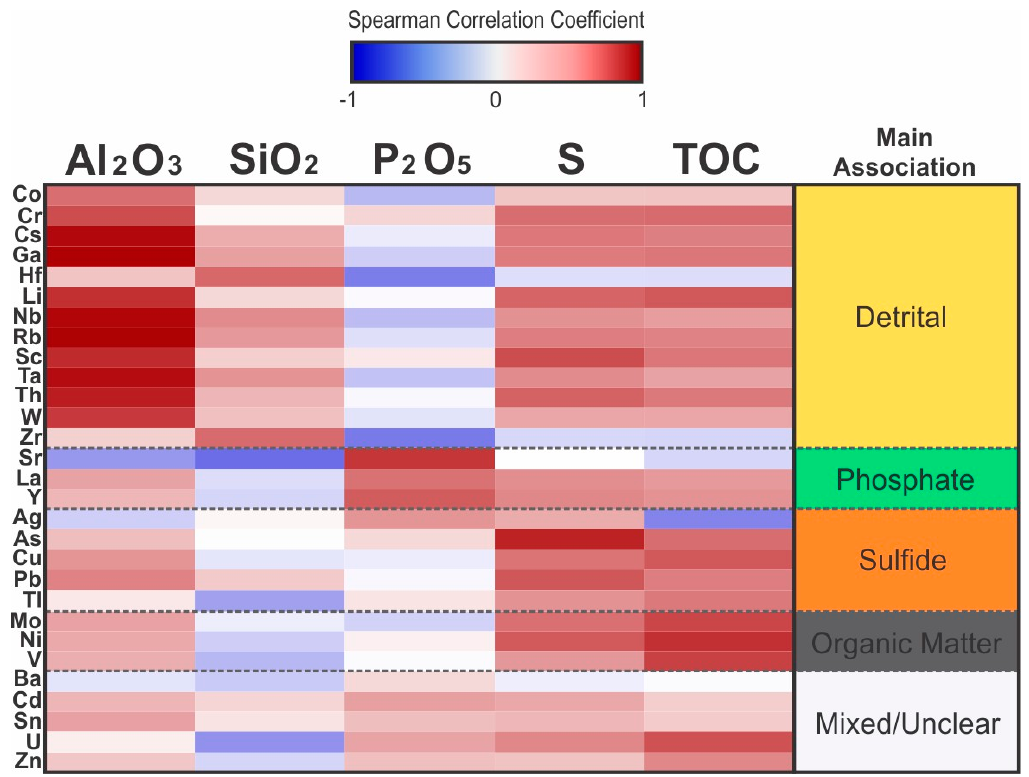
Figure 17. Heat map of the Spearman correlation coefficients between select trace elements and major elements plus TOC from Rock-Eval pyrolysis, organized by the association of element with the detrital fraction of the sediment, phosphate, sulfide, organic matter, and mixed or unclear influence.